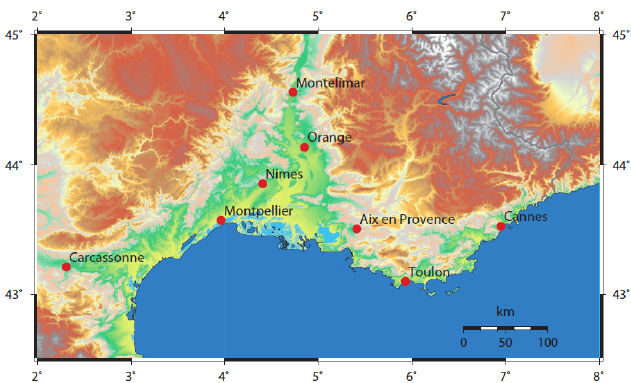
Fig. 1. Map of the studied region (French Mediterranean basin). The red dots indicate the locations of the surface weather stations from which wind speed, temperature and rainfall data are